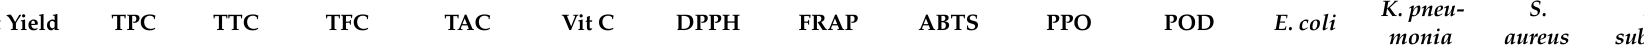
Table 3. Pearson correlation matrix between chemical indices measured from ethanol (70% ( v/v )) extracts from blanched (60, 80 and 100 ◦ C for 1, 3 and 5 min) ‘Wonderful’ pomegranate peel. Variables Extract Yield TPC Extract yield